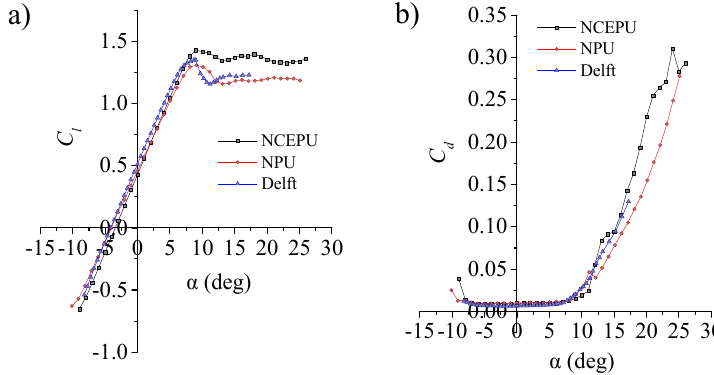
Figure 7. Comparison of experiments ( a ) Lift coefficient, ( b ) Drag coefficient.